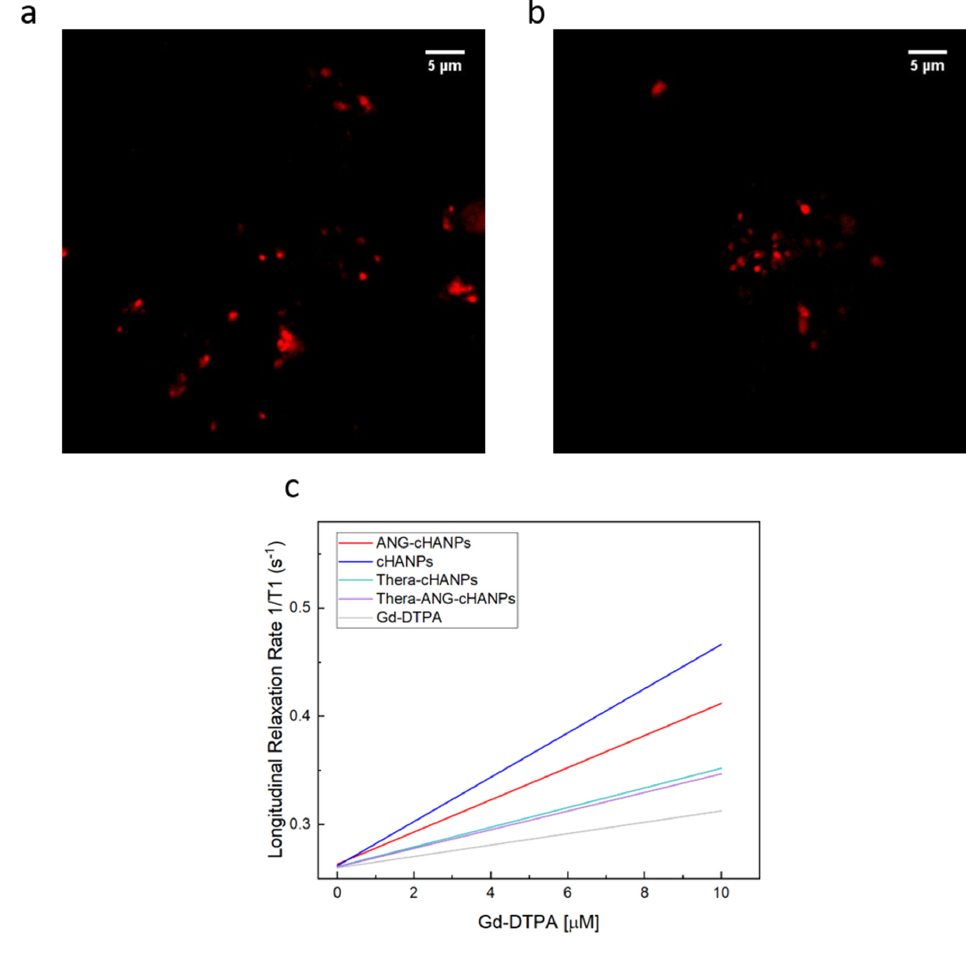
Figure 3. Simultaneous encapsulation of gadolinium-diethylenetriamine pentaacetic acid (Gd-DTPA) and ATTO in cHANPs and ANG-cHANPs. ( a ) Confocal microscopy images of cHANPs; ( b ) Fluorescent microscopy images of ANG-cHANPs; ( c ) Longitudinal relaxation rate (1/T1) in s − 1 of free Gd-DTPA in water (grey line), cHANPs (blue line), and ANG-cHANPs (red line), Thera-cHANPs (cyan line); Thera-ANG-cHANPs (violet line) showing a relaxivity r1 of 3.58, 20.32, 12.08, 9.09 and 8.86 mM − 1 s − 1